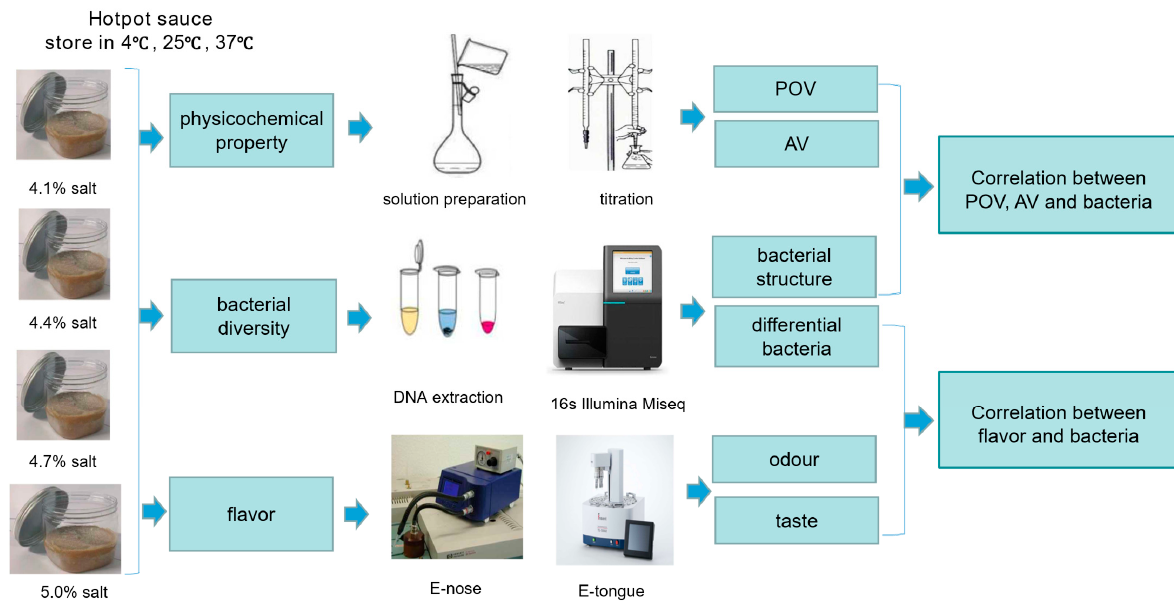
Figure 1. The whole research process.